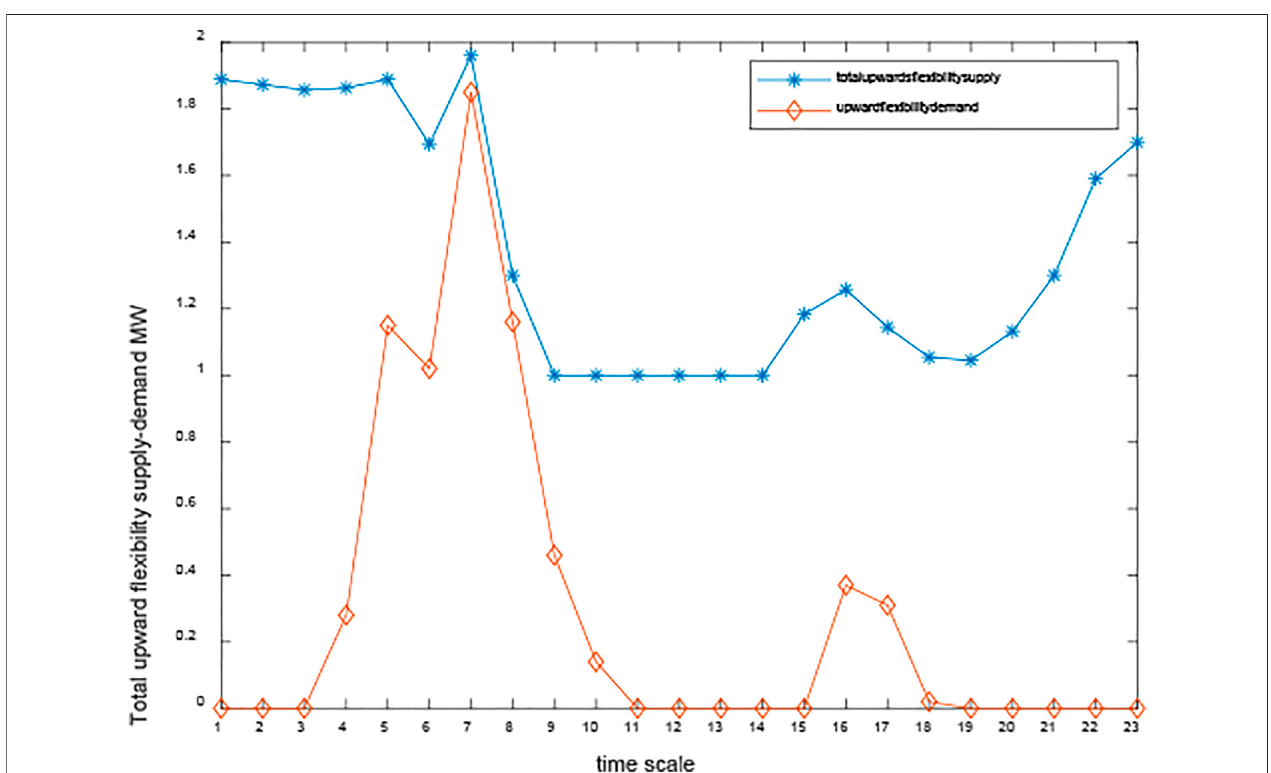
FIGURE 15 | Total upward fl exibility supply – demand of case